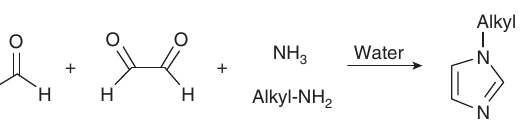
Scheme 2: Synthesis of alkyl imidazoles with ring